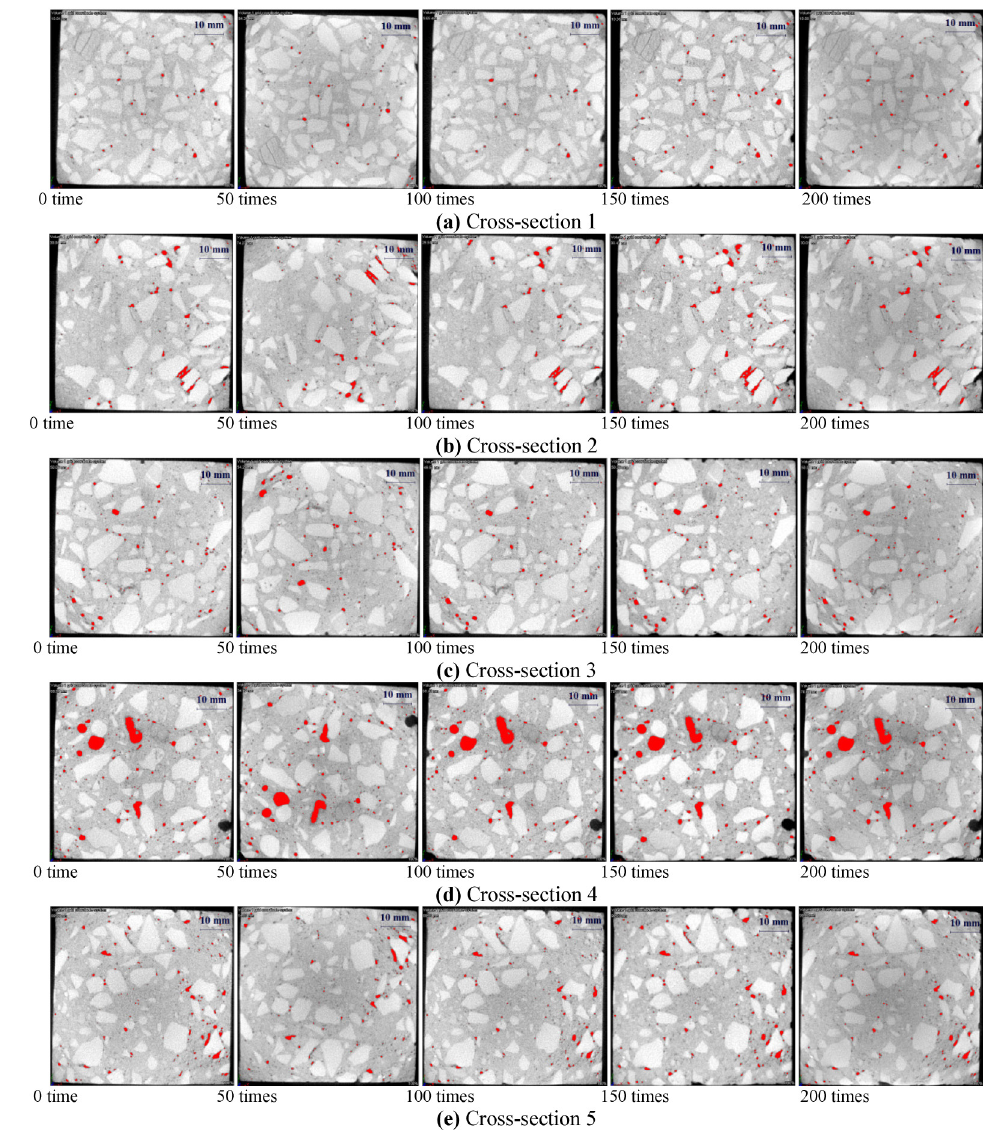
Fig. 13. Changes in the pores of each cross-section in DRY2-1 as the number of freeze-thaw cycles